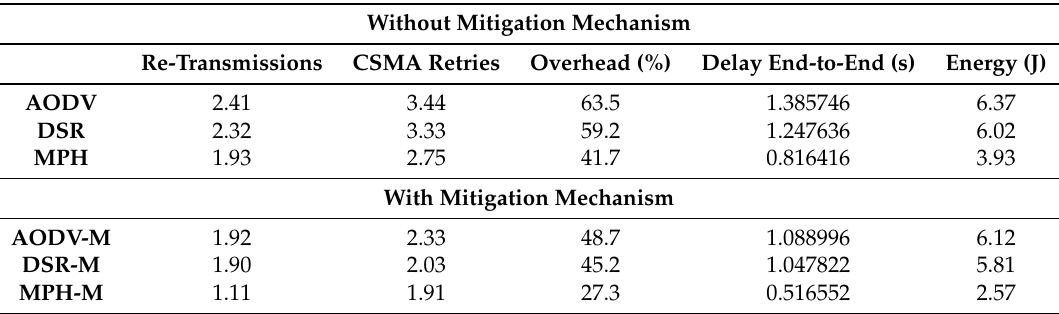
Table 6. Performance metrics per node under 10 packets/s traffic